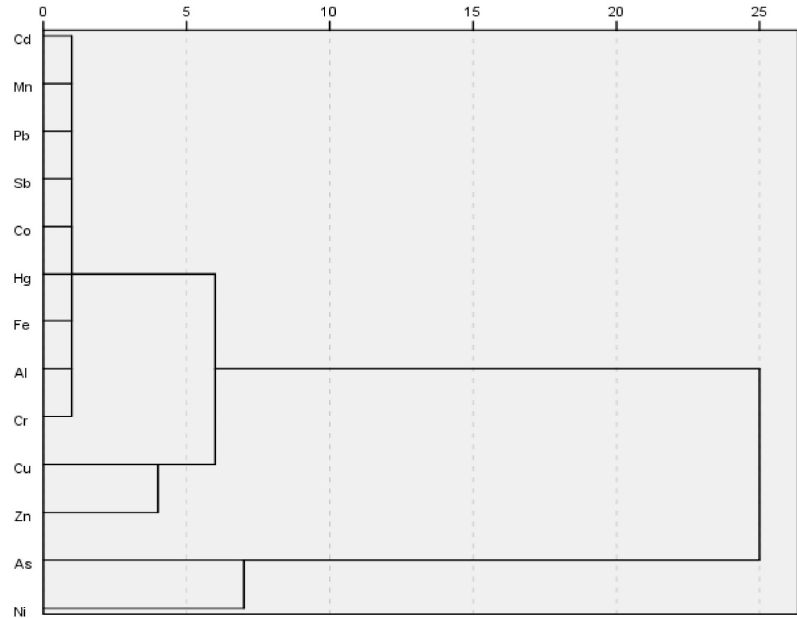
Figure 5. R mode HCA of the investigated HMs. Table 4. Correlation matrices of the investigated